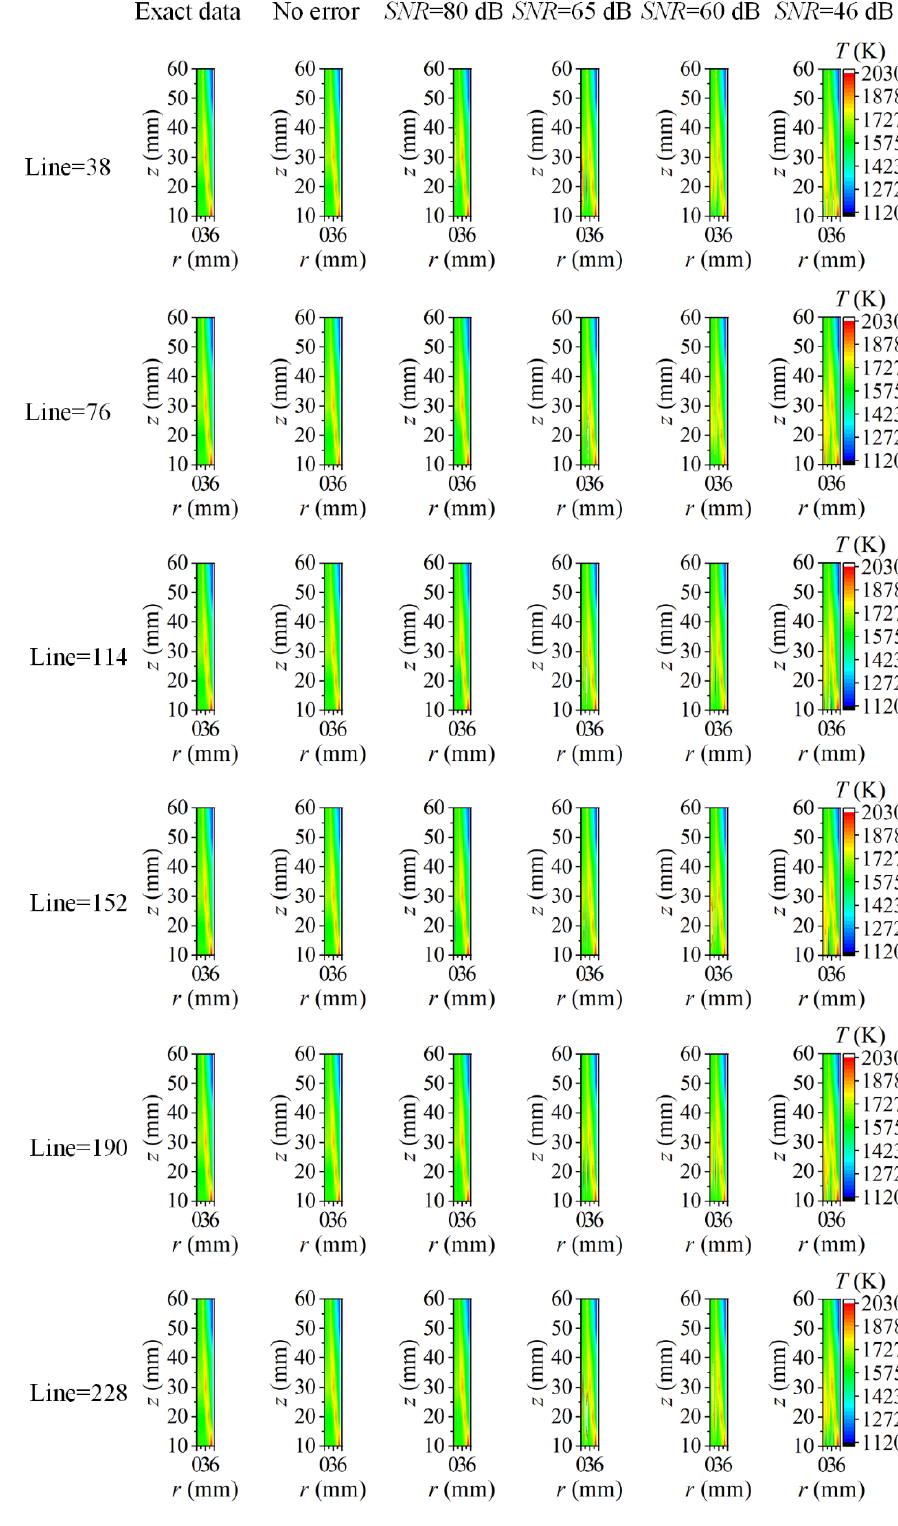
Figure 11. The two-dimensional distribution of reconstructed flame temperature under different ray numbers and different cases of SNR .